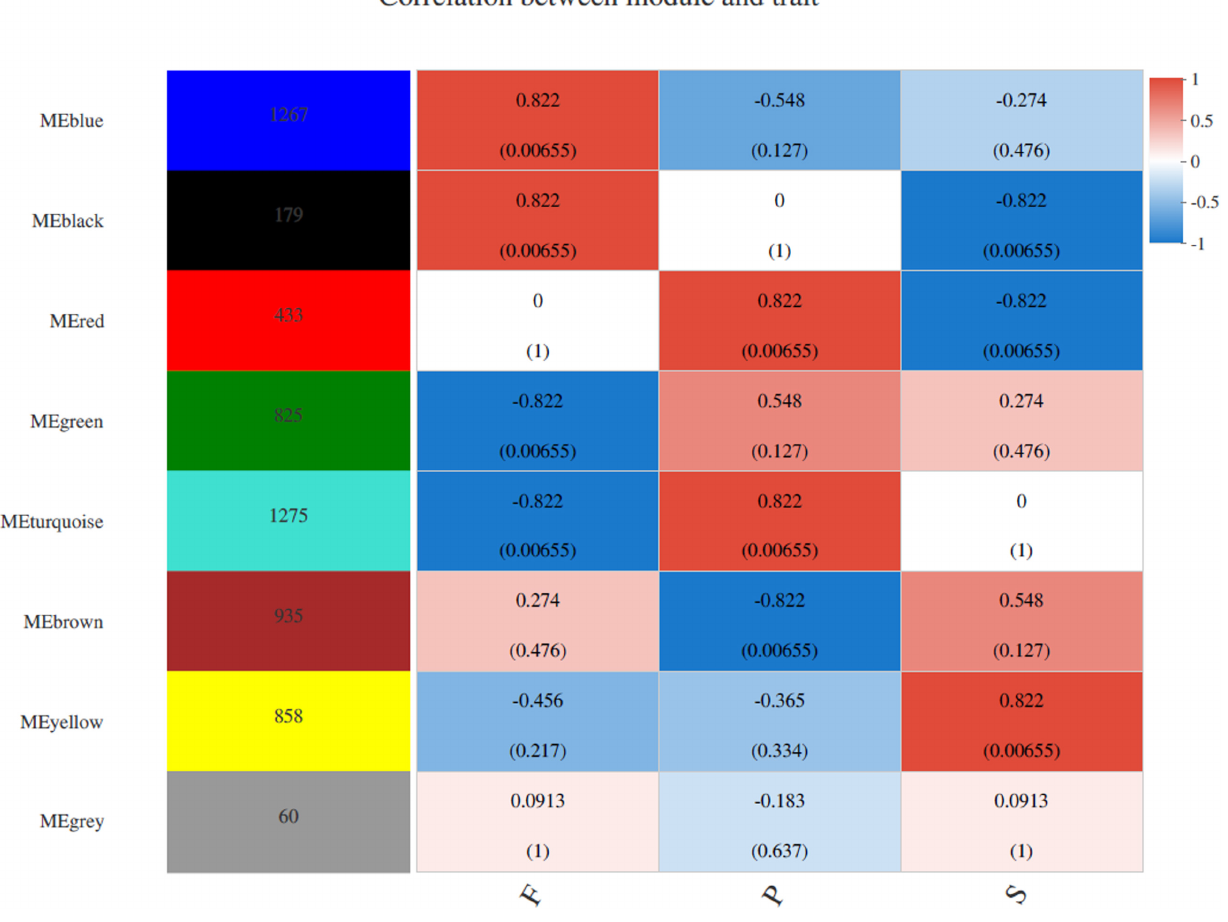
FIGURE 5 | WGCNA of genes in different developmental stages in P. portentosus . Module-trait weighted correlations and corresponding P -values for the identified gene module and their developmental stages. The label color on the right represents the strength of correlation, from 1 (red) to –1 (blue). Each column corresponds to a developmental stage. The eight modules and the number of module member genes are shown on the left panel. The boxes with different color indicated the significant correlation between the module eigengene and the